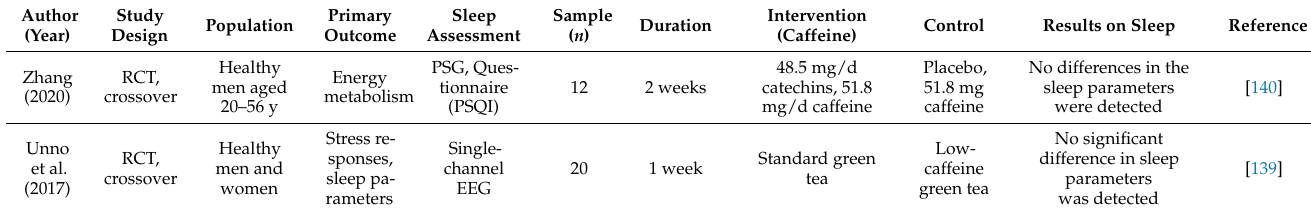
Table 4. Summary of human clinical studies assessing the association between sleep and catechin